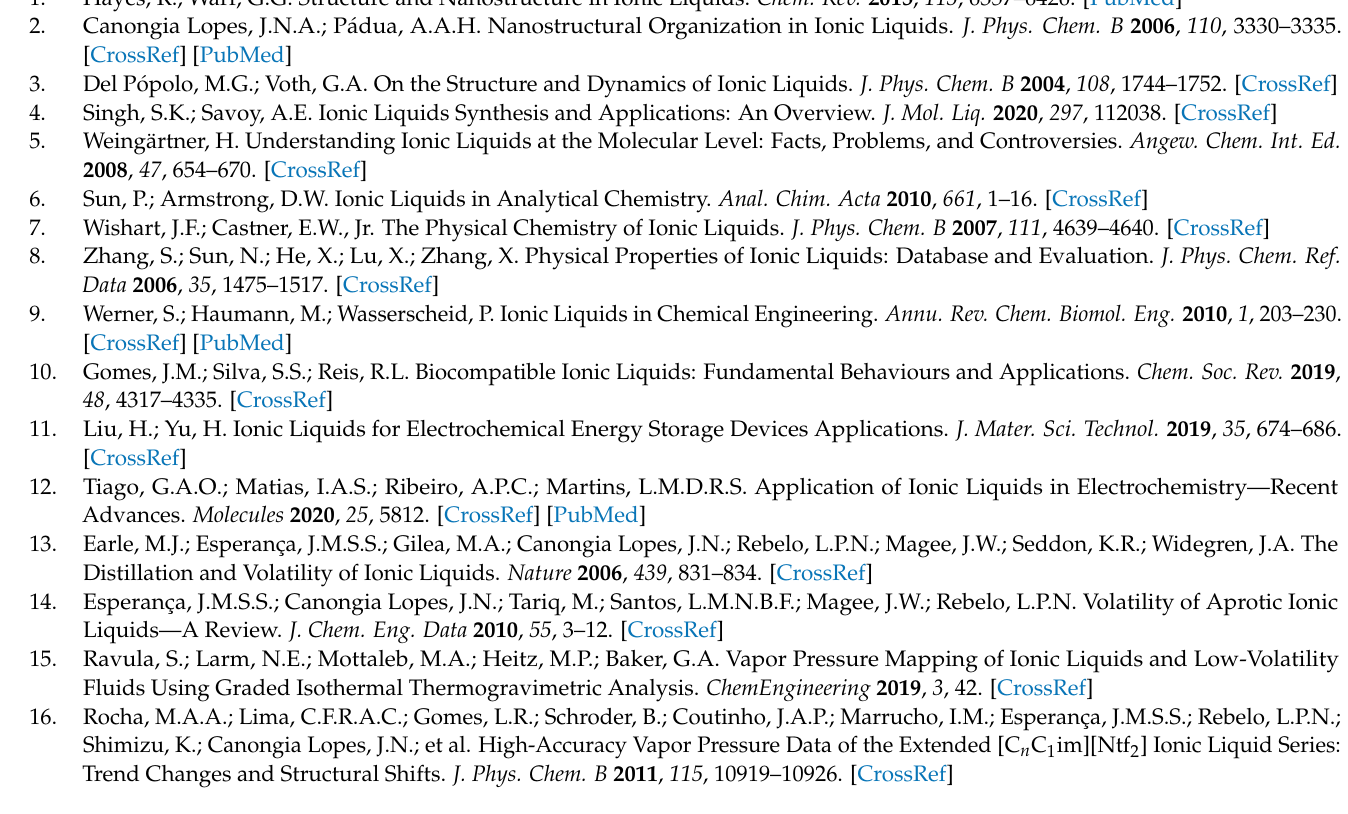
nucleation and growth of ionic liquid films; Figure S5: Morphology of the substrates; Figure S6: Micro- graphs of vapor-deposited [C 2 C 1 im][OTF]; Figure S7: Micrographs of vapor-deposited [C 4 C 1 im][OTF]; Figure S8: Micrographs of vapor-deposited [C 6 C 1 im][OTF]; Figure S9: Micrographs of vapor- deposited [C 8 C 1 im][OTF]; Figure S10: Figure S11: Droplet size distribution of vapor-deposited ionic liquids; Figure S12: Schematic repre- sentation of the number of ionic liquid microdroplets formed and the respective surface coverage as a function of each ionic liquid in the [C n C 1 im][OTF] series; Table S1: Experimental conditions for the physical vapor deposition of each ionic